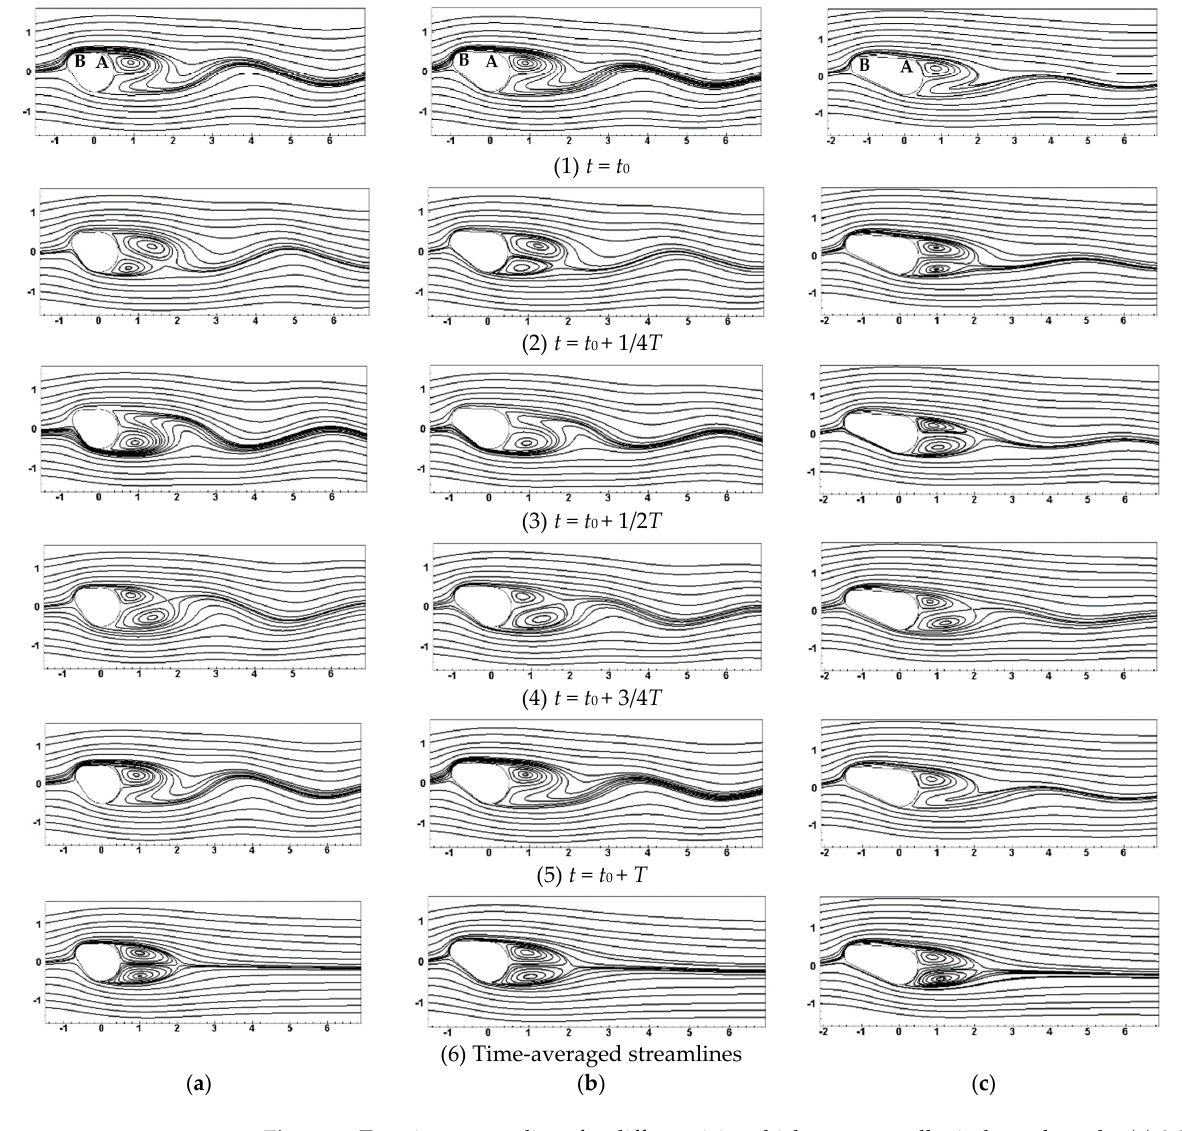
Figure 8. Transient streamlines for different icing thickness at small wind attack angle: ( a ) 0.25–27°, ( b ) 0.5–20°, ( c ) 1.0–14°. (A and B are the boundary layer separation points in the picture)